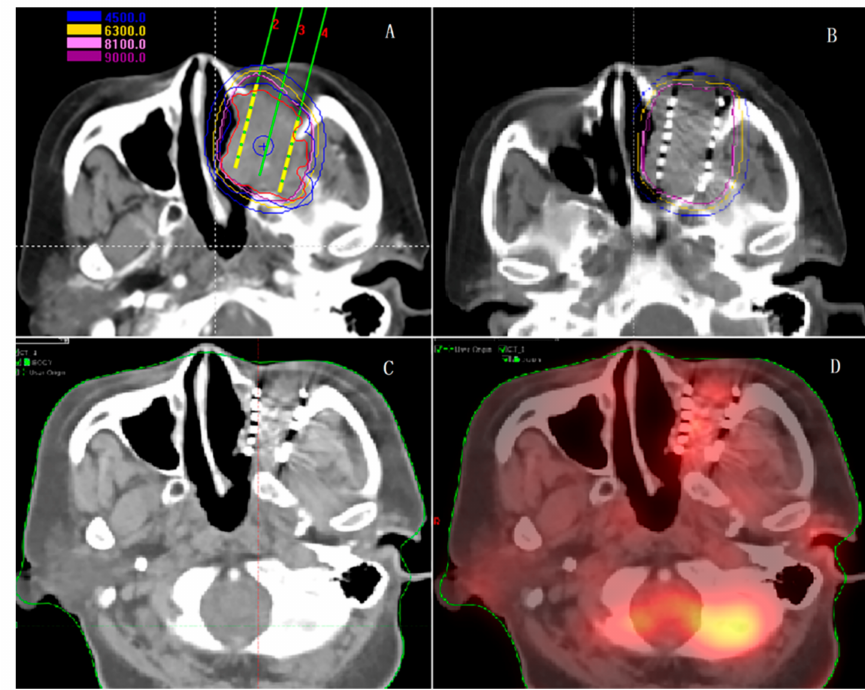
Figure 3. Clinical stereotactic ablative brachytherapy (SABT) practice for head and neck cancers. ( A ): Preoperative planning for a head and neck cancer; ( B ): Intraoperative replan and seed implanta- tion; ( C , D ): the cancer is shrinking 3 months after seed implantation with low in-taking of fluorinated deoxy-glucose on the PET/CT image (SUV <